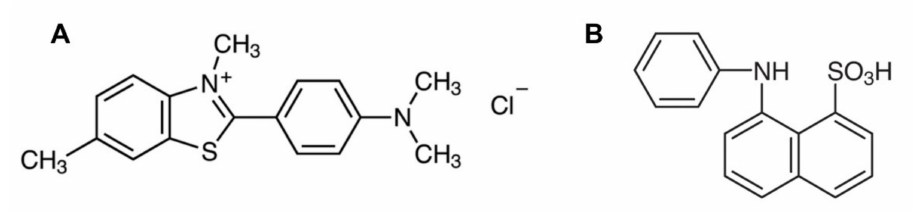
Figure 14. Chemical structure of ThT ( A ) and ANS ( B ) fluorescence